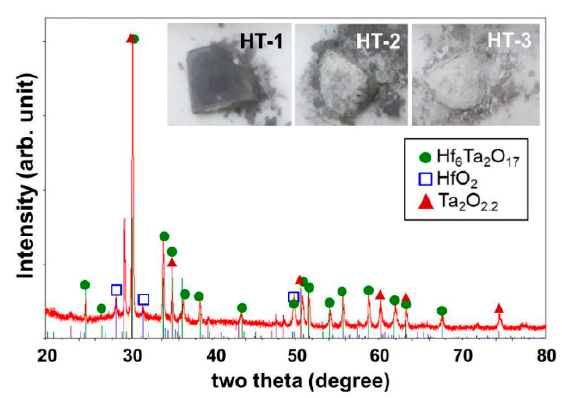
Figure 7. XRD pattern of the residual powder collected from HT-3 after heat treatment in a 4% H 2 -Ar atmosphere.